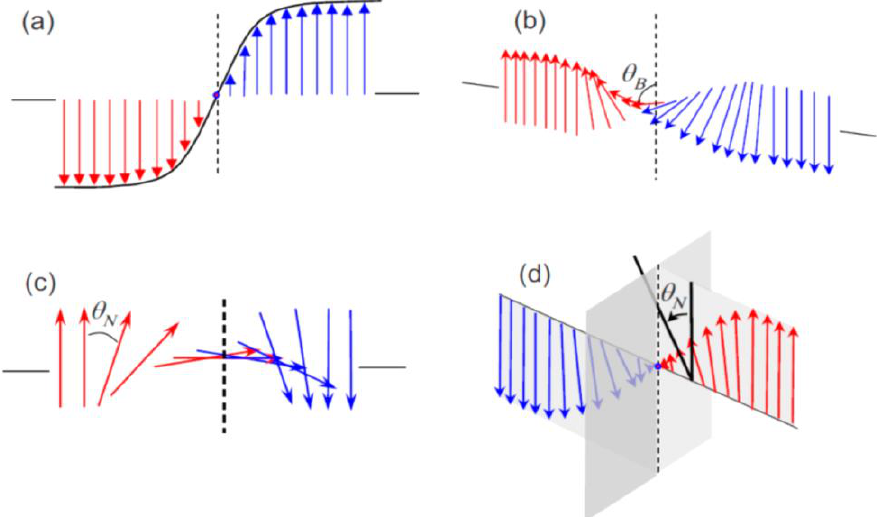
Figure 17. Different types of domain walls: ( a ) Ising type; ( b ) Bloch type; ( c ) Néel type; and ( d ) Mixed Ising-Néel type walls. A mixed Ising-Bloch type would look similar to ( d ) except that the rotation would be out of the plane of the polarization vector. (Reprinted with permission from [355]; Copyright 2009 by the American Physical Society)